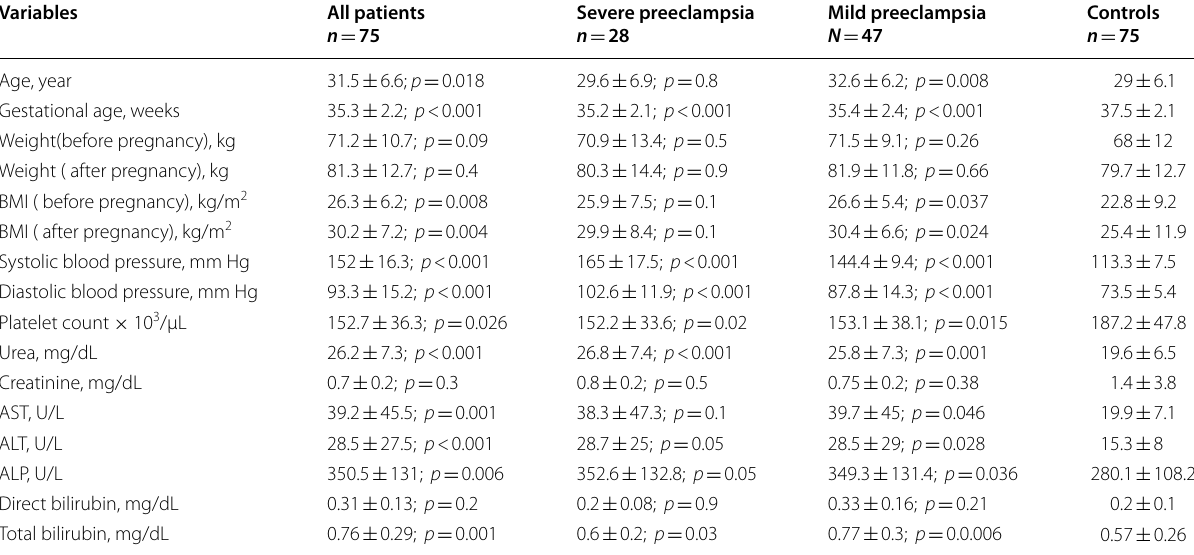
Table 1 Characteristics of patients and controls